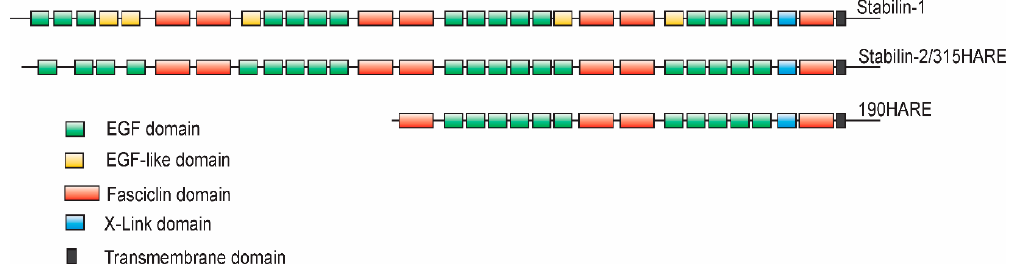
Figure 1. Topology of Stabilin-1 and Stabilin-2. The overall topologies of human Stabilin-1 and human Stabilin-2, including the 190HARE, are very similar with an overall protein sequence identity of 39% and similarity of 56% between the two large receptors. The topology algorithm was derived using the SMART program and the homology was calculated using BLAST program of the National Center for Biotechnology Information.